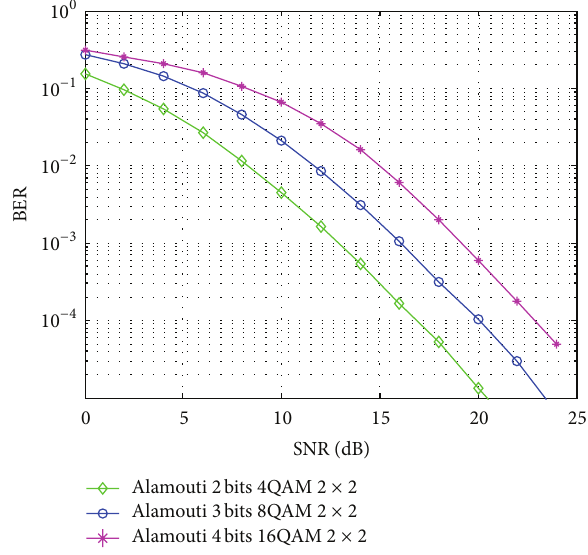
Figure 5: The received SNR versus BER in Alamouti with 3 different